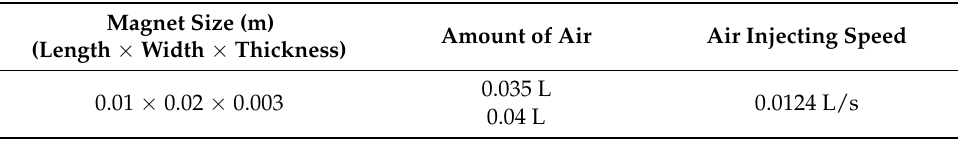
Figure 18. Result of jump forces depending on magnetic force test. Table 5. Conditions for the robot used in the comparison of jump forces depending on the volume of air injected test.